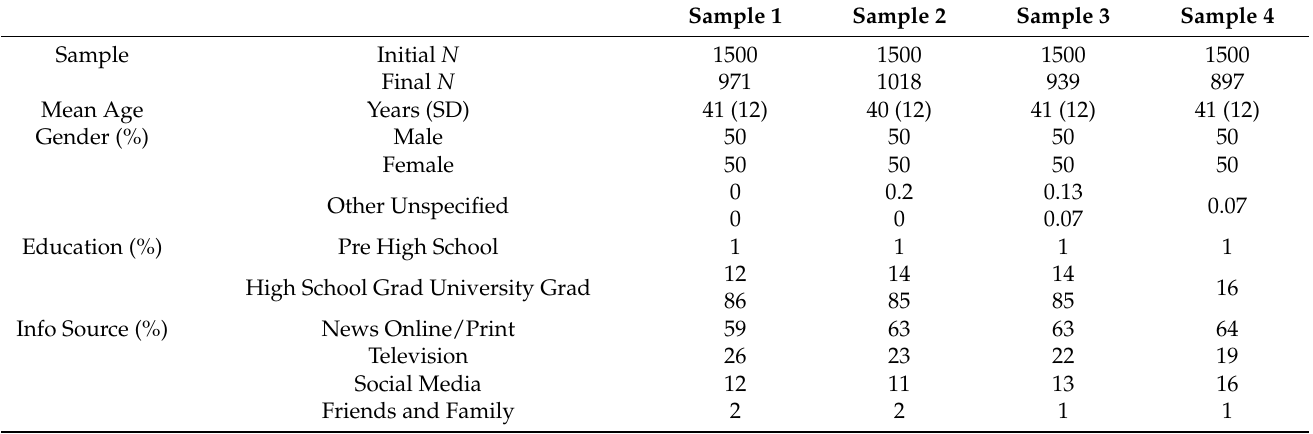
Table 1. Demographic information relevant to each sample. Edu: Education. Age is presented as the sample mean and standard deviation in years. Final N indicates the analyzed sample number after screening for the comprehension check item. Note: ‘Radio’ and ‘Other’ information source options are not displayed as they formed less than 1% of each sample, and percentages are rounded to the nearest integer if greater than